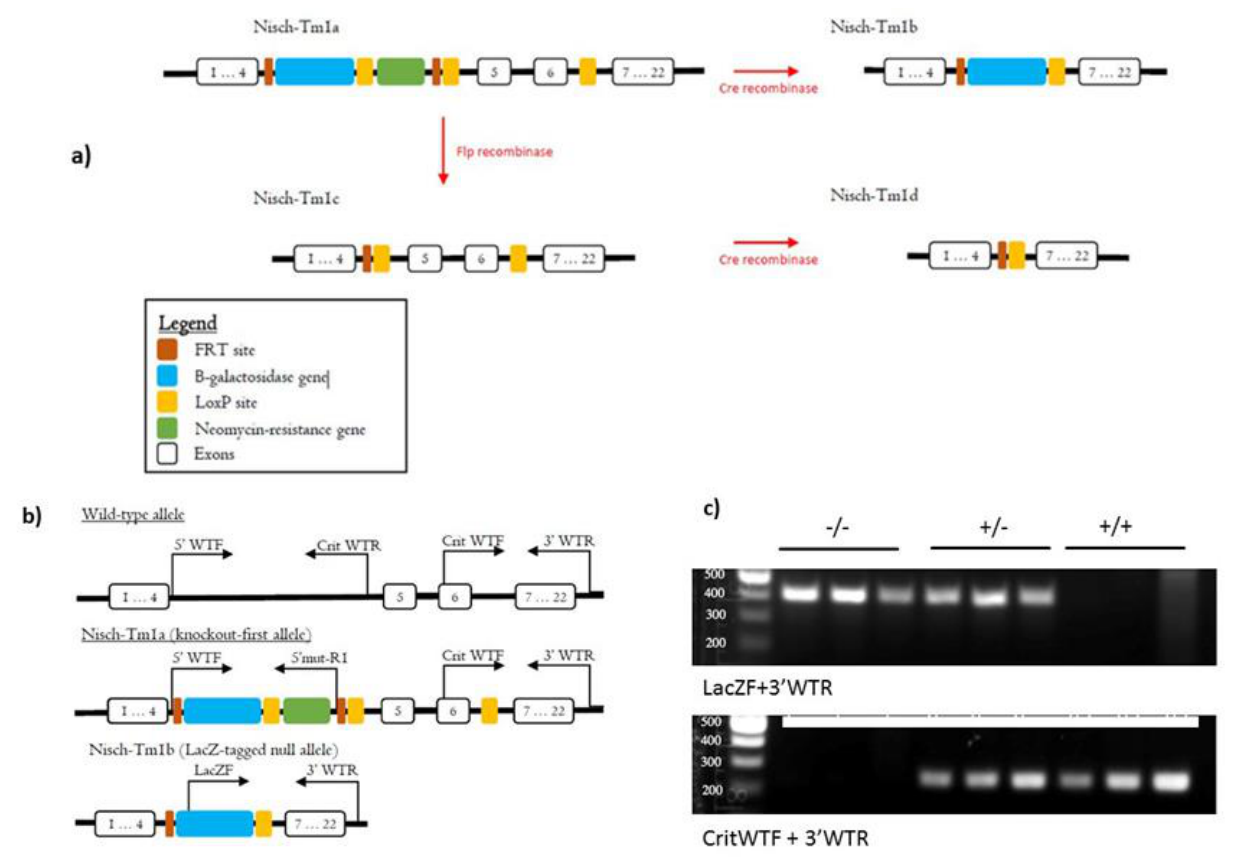
Figure 1. Knockout mice were generated using a reporter-tagged allele: ( a ) Nisch-Tm1a mice are the conditional knockout-first allele and can be crossed with either a Cre recombinase that recognizes LoxP sites or an Flp recombinase that recognizes FRT sites. The Cre recombinase cross yields Nisch-Tm1b mice, which have a LacZ-tagged null allele. The Flp recombinase cross yields Nisch-Tm1c mice, which have a conditional-ready allele. Nisch-Tm1c mice may be subsequently crossed with Cre recombinase to yield Nisch-Tm1d mice, which have a tissue-specific null allele; ( b ) Tm1b mice were genotyped using the primers shown in the figure. The wild-type allele can be identified by using either 5′ WTF and Crit WTR or Crit WTF and 3′WTR. These primers amplify regions surrounding exons 5 and 6, the targeted deletions for the knockout model. Mice with the conditional allele can be genotyped by the presence of a band when primers 5′ WTF and 5′mut-R1 were used for PCR. The introduction of the LacZ-containing cassette is distinguished from the wild-type PCR primer sets due to the product not being able to anneal after the extension period, secondary to the longer sequence. Finally, the knockout allele was detected by using primers LacZF and 3′WTR. The deletion of the exons 5 and 6 prevent primers that would otherwise detect the wild-type or Tm1a allele; ( c ) PCR products for primer set LacZF and 3′WTR yield a band at 400 bp, indicating the dele- tion of the critical region containing exons 5 and 6; PCR products for primer set Crit WTF and 3′WTR yield a band at 210 bp, indicating the wild-type allele. Lanes 1–3 (after the marker) contain DNA from Nisch −/− MEF cells, lanes 4–6 contain DNA from Nisch +/− MEF cells, and lanes 7–9 contain DNA from Nisch +/+ MEF cells. Experiments were performed in triplicate and repeated two times.